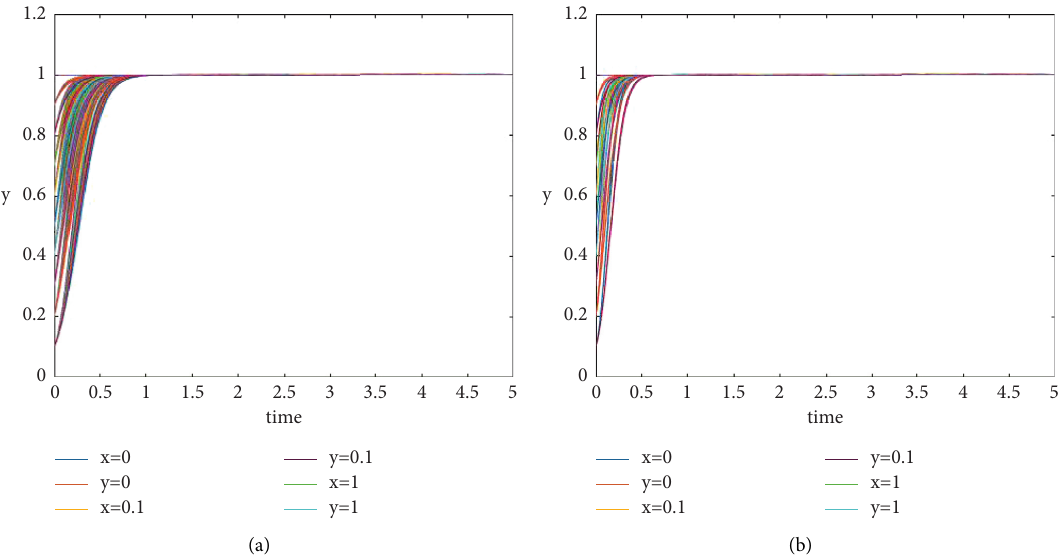
Figure 9: Evolution of the state of choice of air pollution control behaviour in the Beijing-Tianjin-Hebei region with constraints.